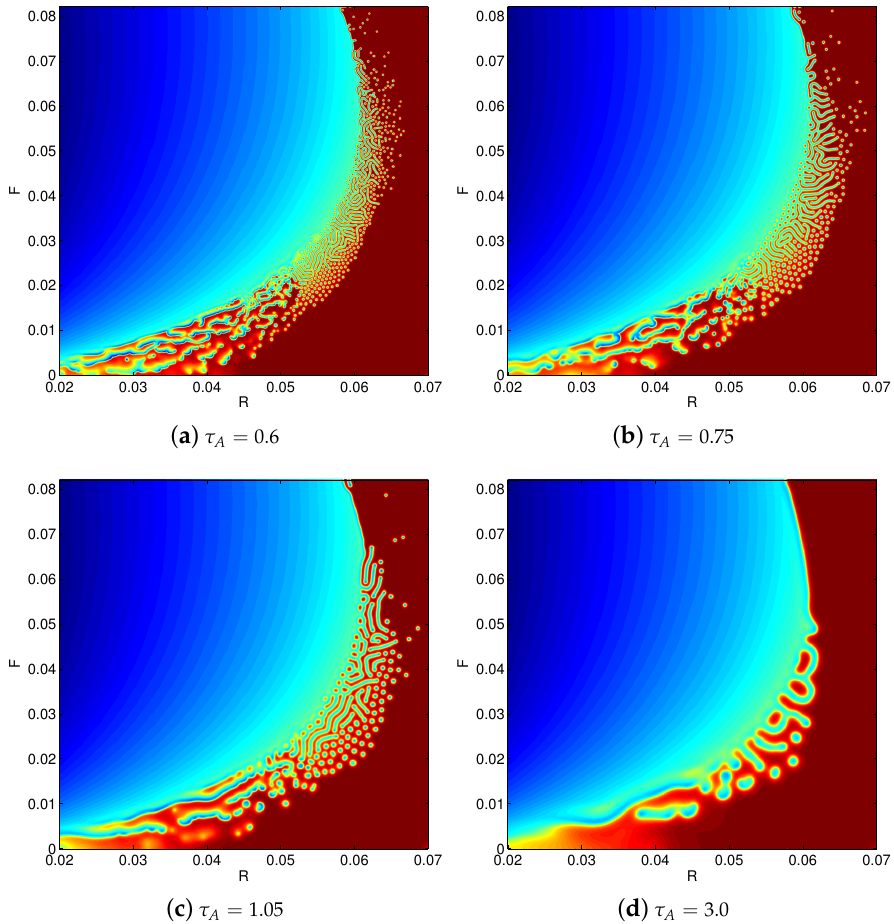
Figure 3. Phase portraits of RLBM simulations of a GSRDS with different relaxation parameters τ A